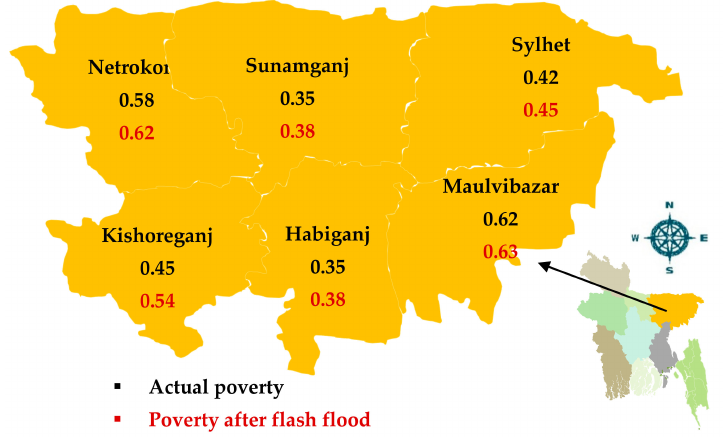
Figure 15. Changing poverty rate caused by flash floods in northeastern